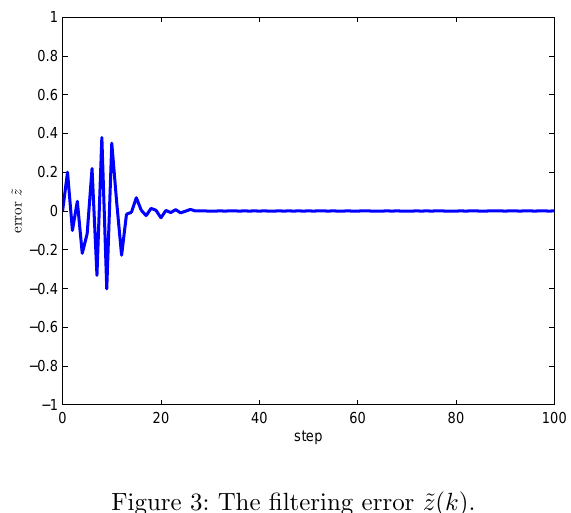
Figure 3: The filtering error ˜ z ( k ).